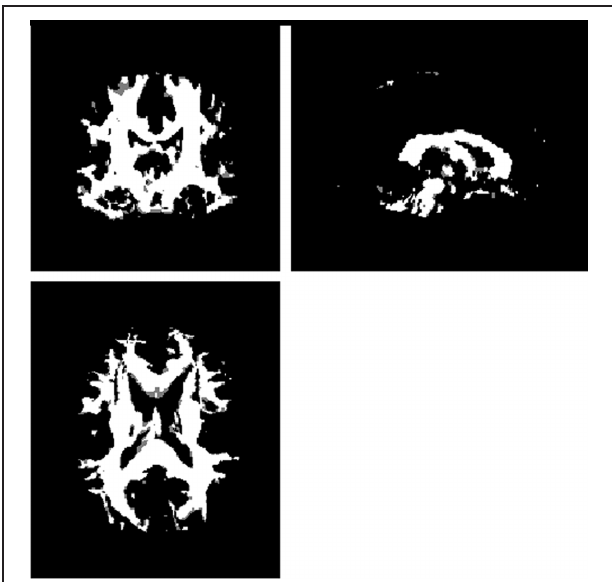
mask to increase our power to detect longitudinal change. The white matter mask was created by applying a threshold of 0.5 to the mean FA map of all subjects, and then binarizing the resulting image. This figure shows the white matter mask in three orthogonal directions. The left side of the mask is patient left and the right is patient